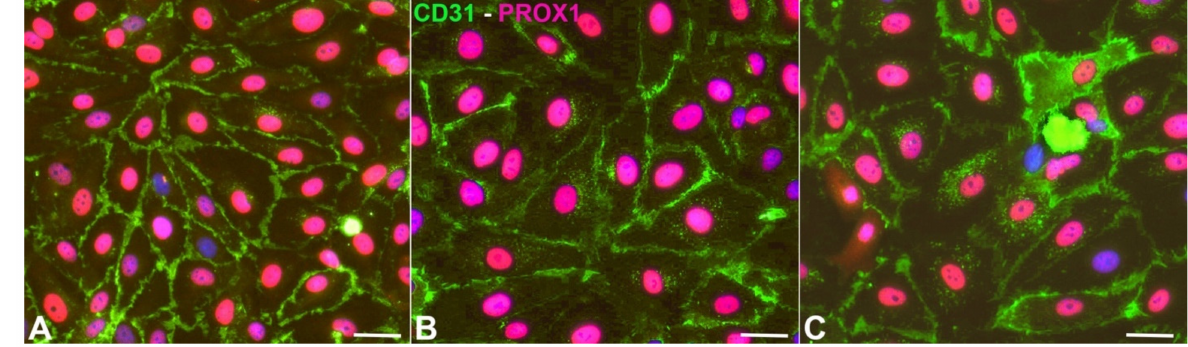
Figure 1. Expression of CD31 (green) and PROX1 (magenta) in HD-LECc5 ( A ), HD-LECc6 ( B ), and HD-LECc7 ( C ). Bar = 15 µ m. Pictures were acquired with AxioImager Z.1 (Zeiss, Göttingen,